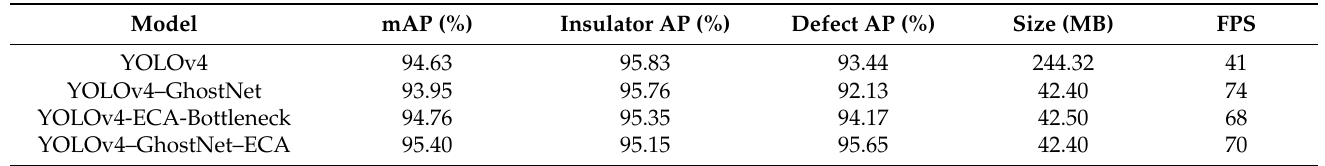
Table 1. Comparison of the effects of improved attention mechanisms.